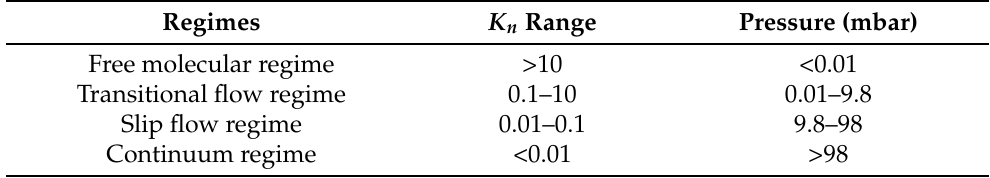
Table 1. Flow regime, corresponding Knudsen number K n , and calculated pressure based on charac- teristic length L C of